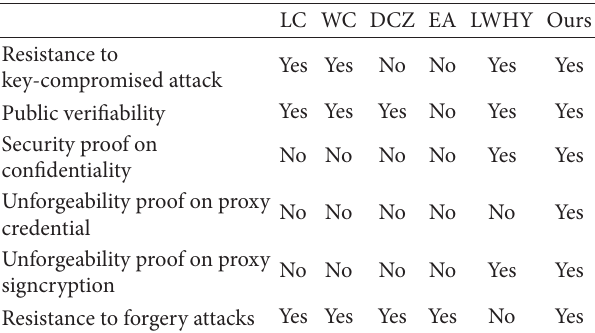
Table 1: Security strength comparison among proxy signcryption schemes.